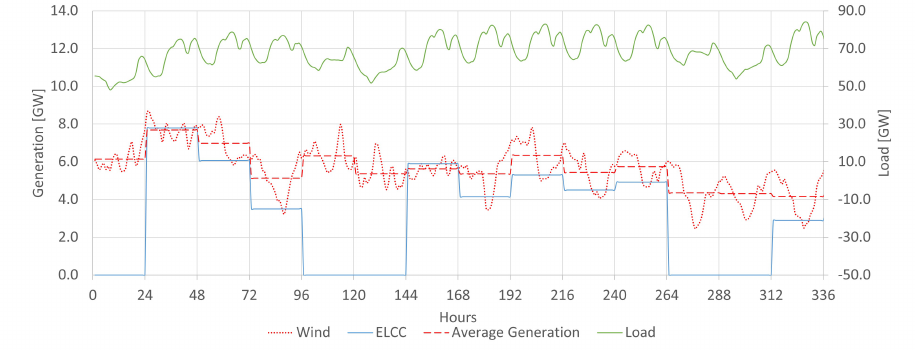
Figure 11. Load, wind generation and ELCC in an hourly basis for the first two weeks of